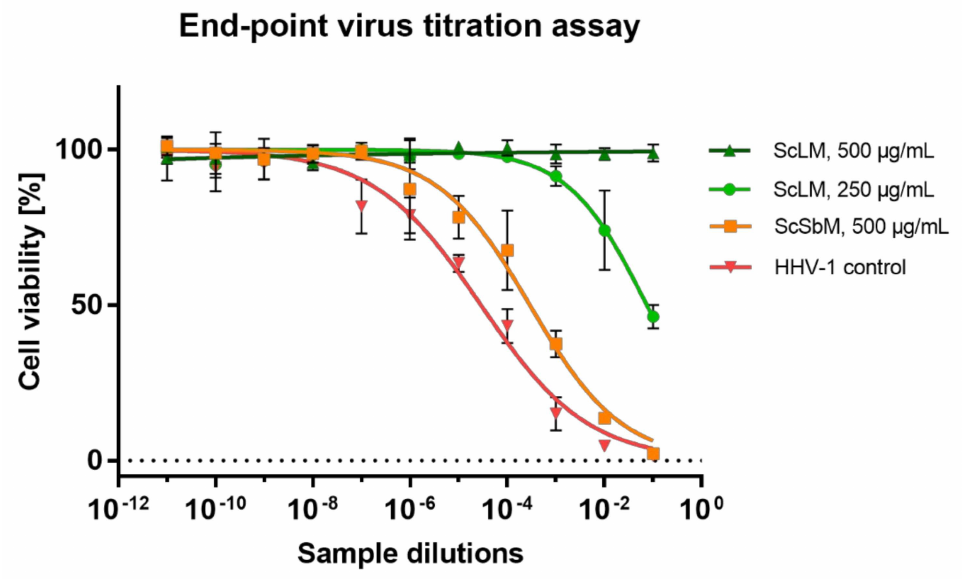
Figure 6. Endpoint dilution assay of HHV-1 infectious titre in virus-infected VERO cells treated with S. campanulata